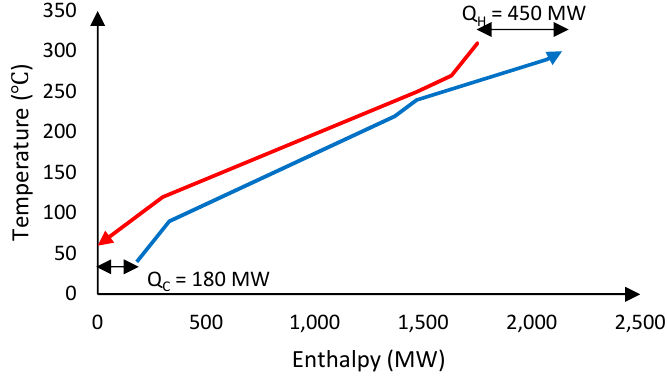
Figure 1. Composite curves for the nominal case .